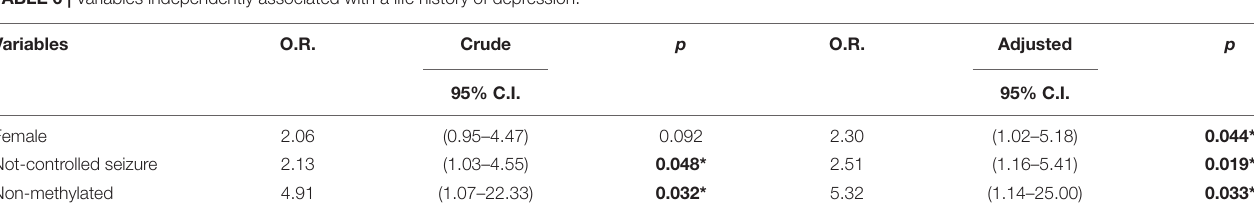
TABLE 6 | Variables independently associated with a life history of